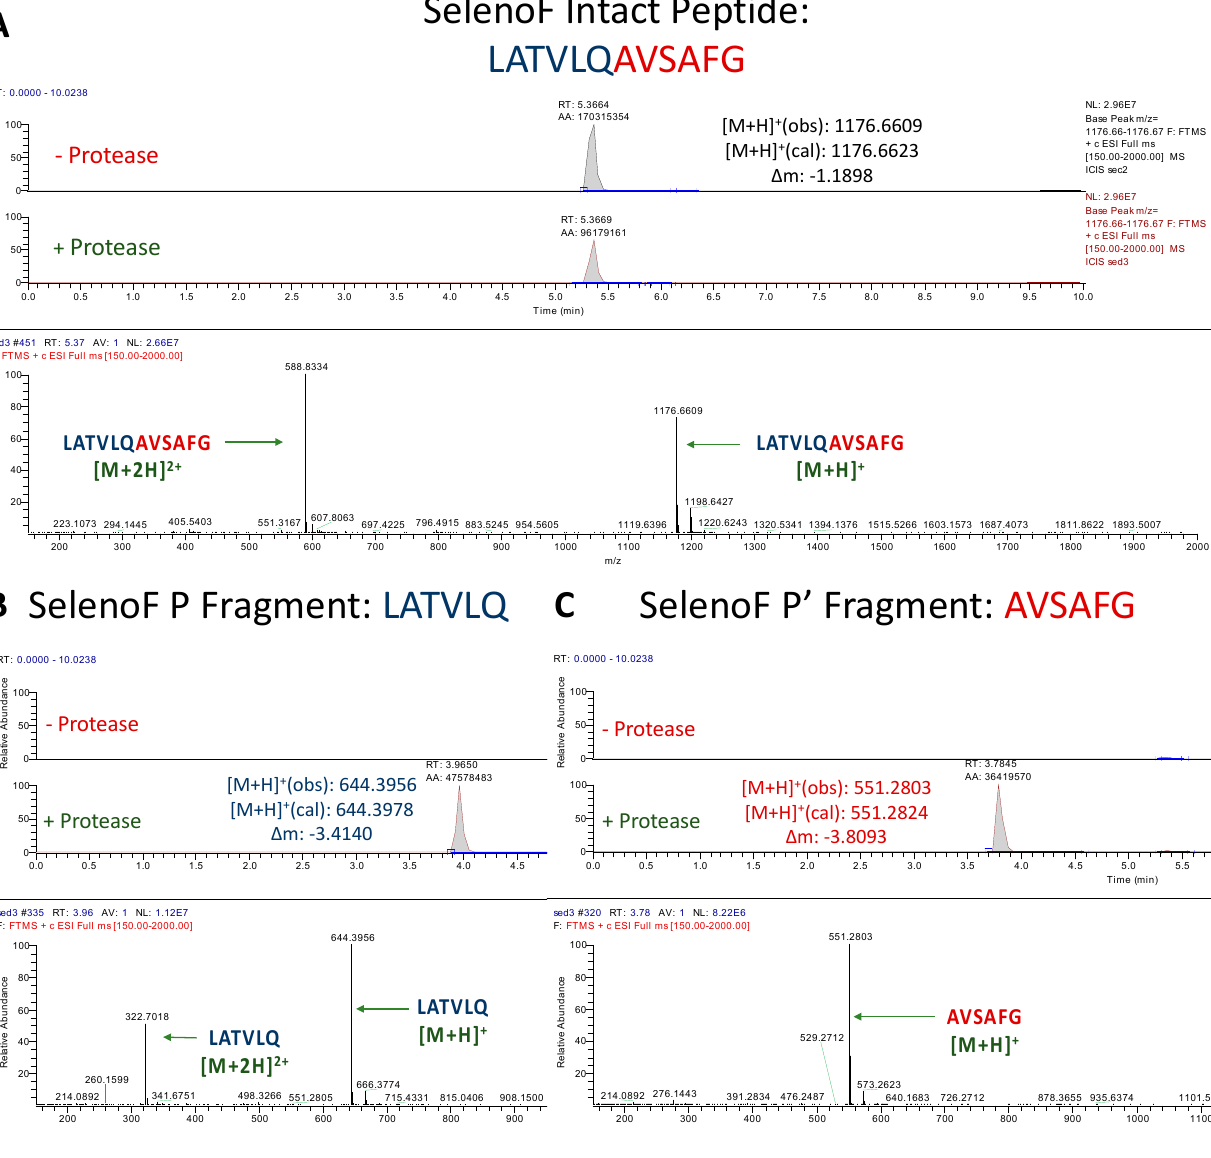
Figure 6. UPLC-MS Data for SelenoF Peptide. Depicted are the extracted ion chromatograms for the samples without protease and with protease ( top ) and the mass spectra ( bottom ) for ( A ) the Intact Peptide, ( B ) the P Fragment, and ( C ) the P ′ Fragment. The base peaks for the P and P ′ Fragments had normalization levels of 2.96 × 10 7 and 1.12 × 10 7 , respectively. High resolution mass spectrometric analysis corroborates the identities of each base peak in the corresponding extracted ion chromatogram.